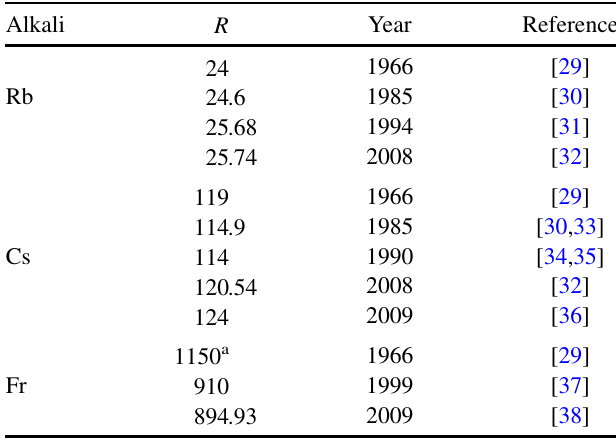
TABLE III. Calculations of the enhancement factor R for the ground state of heavy alkali